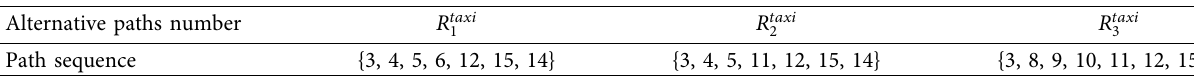
Table 6: Alternative paths for taxis.